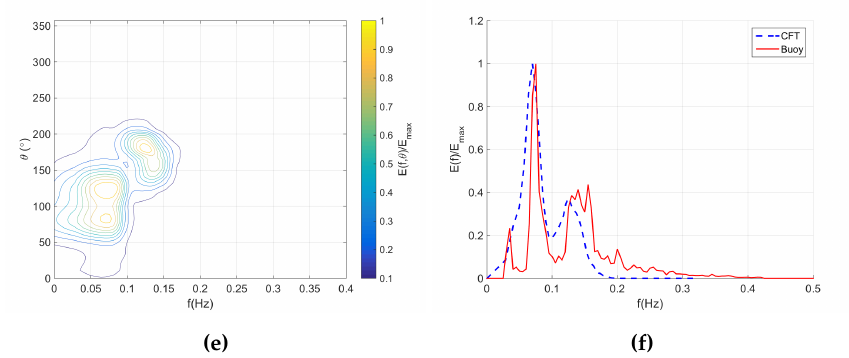
Figure 9. A field data example for wave spectrum estimation using the CFT with the ARPM. Data was recorded on 1 December 2008 at 12:08 PM ( a–f ): ( a , c , e ) The directional wave spectrum estimated in the first, second and third iteration, respectively; ( b , d , f ) The frequency wave spectrum estimated from the radar data in the first, second and third iteration respectively and overlaid on the ground truth frequency wave spectrum.